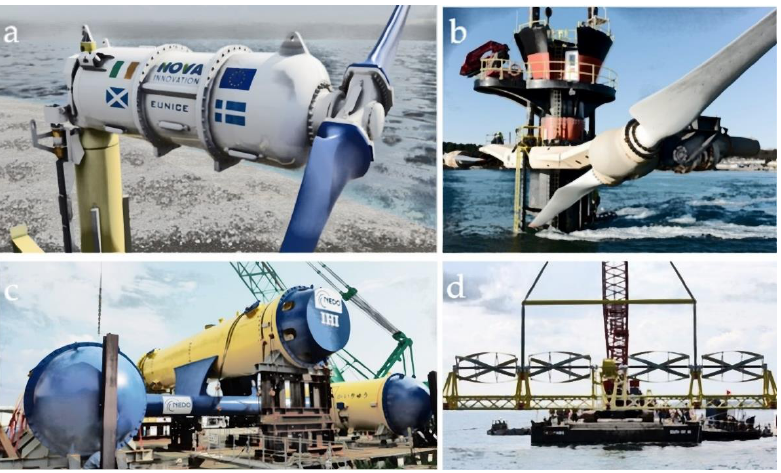
Figure 4. The hydrokinetic devices selected for the techno-econmic analysis: ( a ) NOVA M100-D turbine, with permission of [51]. ( b ) Sea Gen turbine, adapted from [52]. ( c ) Kairyu turbine, adapted from [49]. ( d ) TidGen turbine, with permission of [50]. Table 1. Technical specifications of the turbines considered in this study.